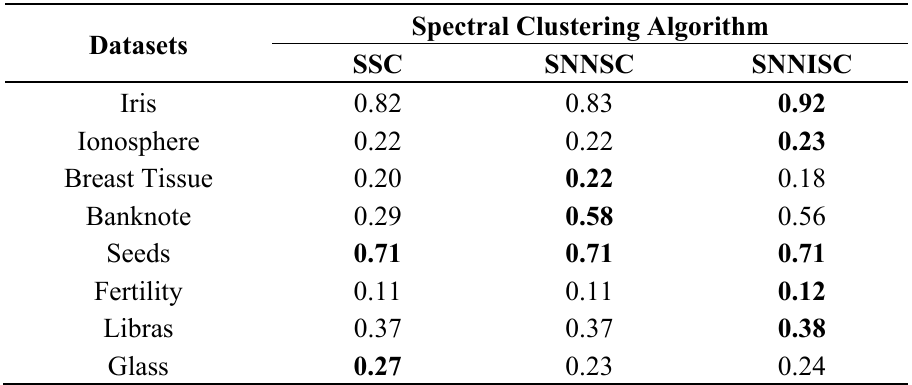
Table 4. The results of ARI on the UCI Machine Learning